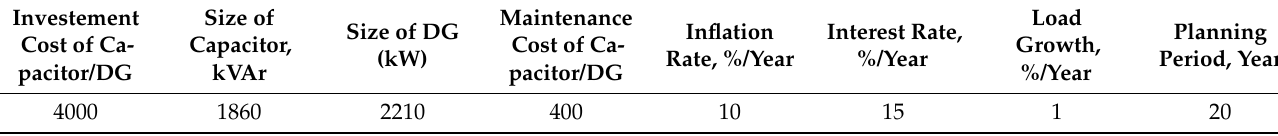
Table 7. Initial data of the